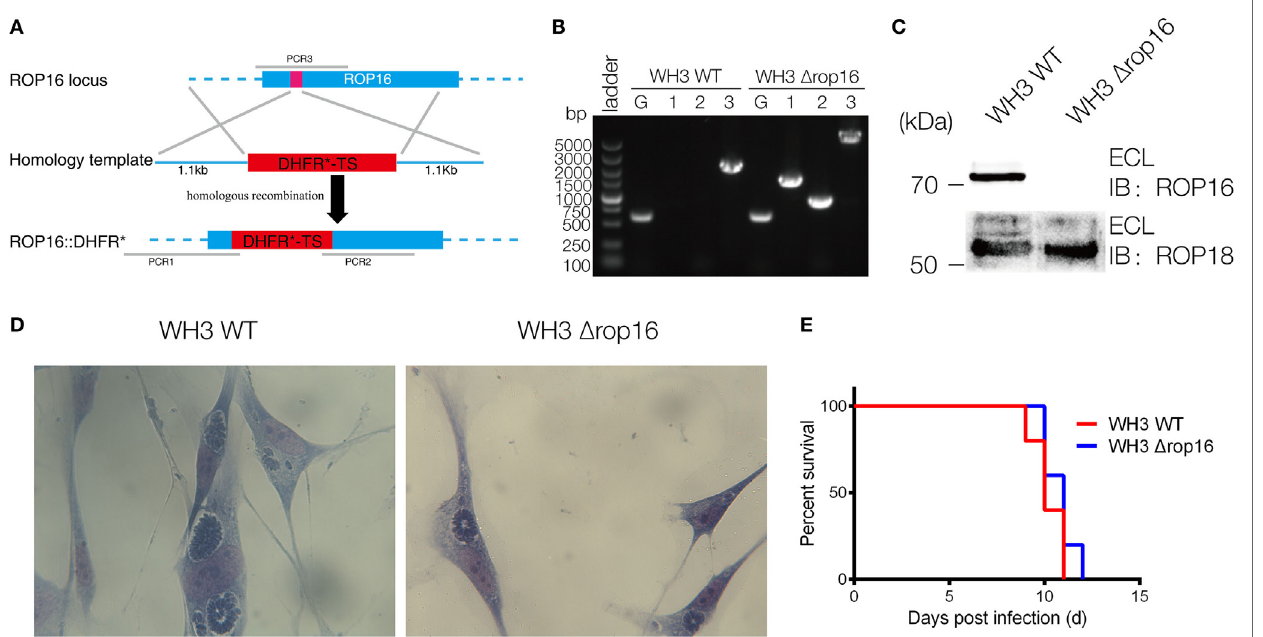
FigUre 1 | Construction of the WH3 Δ rop16 strain of Toxoplasma gondii type Chinese 1 by using CRISPR-Cas9 technology. (a) Schematic of CRISPR/CAS9 strategy for inactivation of rop16 by inserting pyrimethamine-resistant DHFR (DHFR*) and PCR identification of single clone. (B) PCR identification of WH3 Δ rop16 T. gondii strain. G represents the GRA1 promoter positive control, as shown in Figure 1a . 1: PCR1 fragment; 2: PCR2 fragment, 3: PCR3 fragment. PCR1 and PCR2 examined the integration of DHFR-TS* into corresponding genes, and PCR3 checked the deletion of ROP16 sequences. (c) Western blotting for detection of ROP16 expression in WH3 WT and WH3 Δ rop16 . Rabbit polyclonal antibody against ROP18 was used as the control. (D) The number of parasites per parasitophorous vacuole of WH3 Δ rop16 or WH3 WT. (e) Mouse survival after inoculation with T. gondii